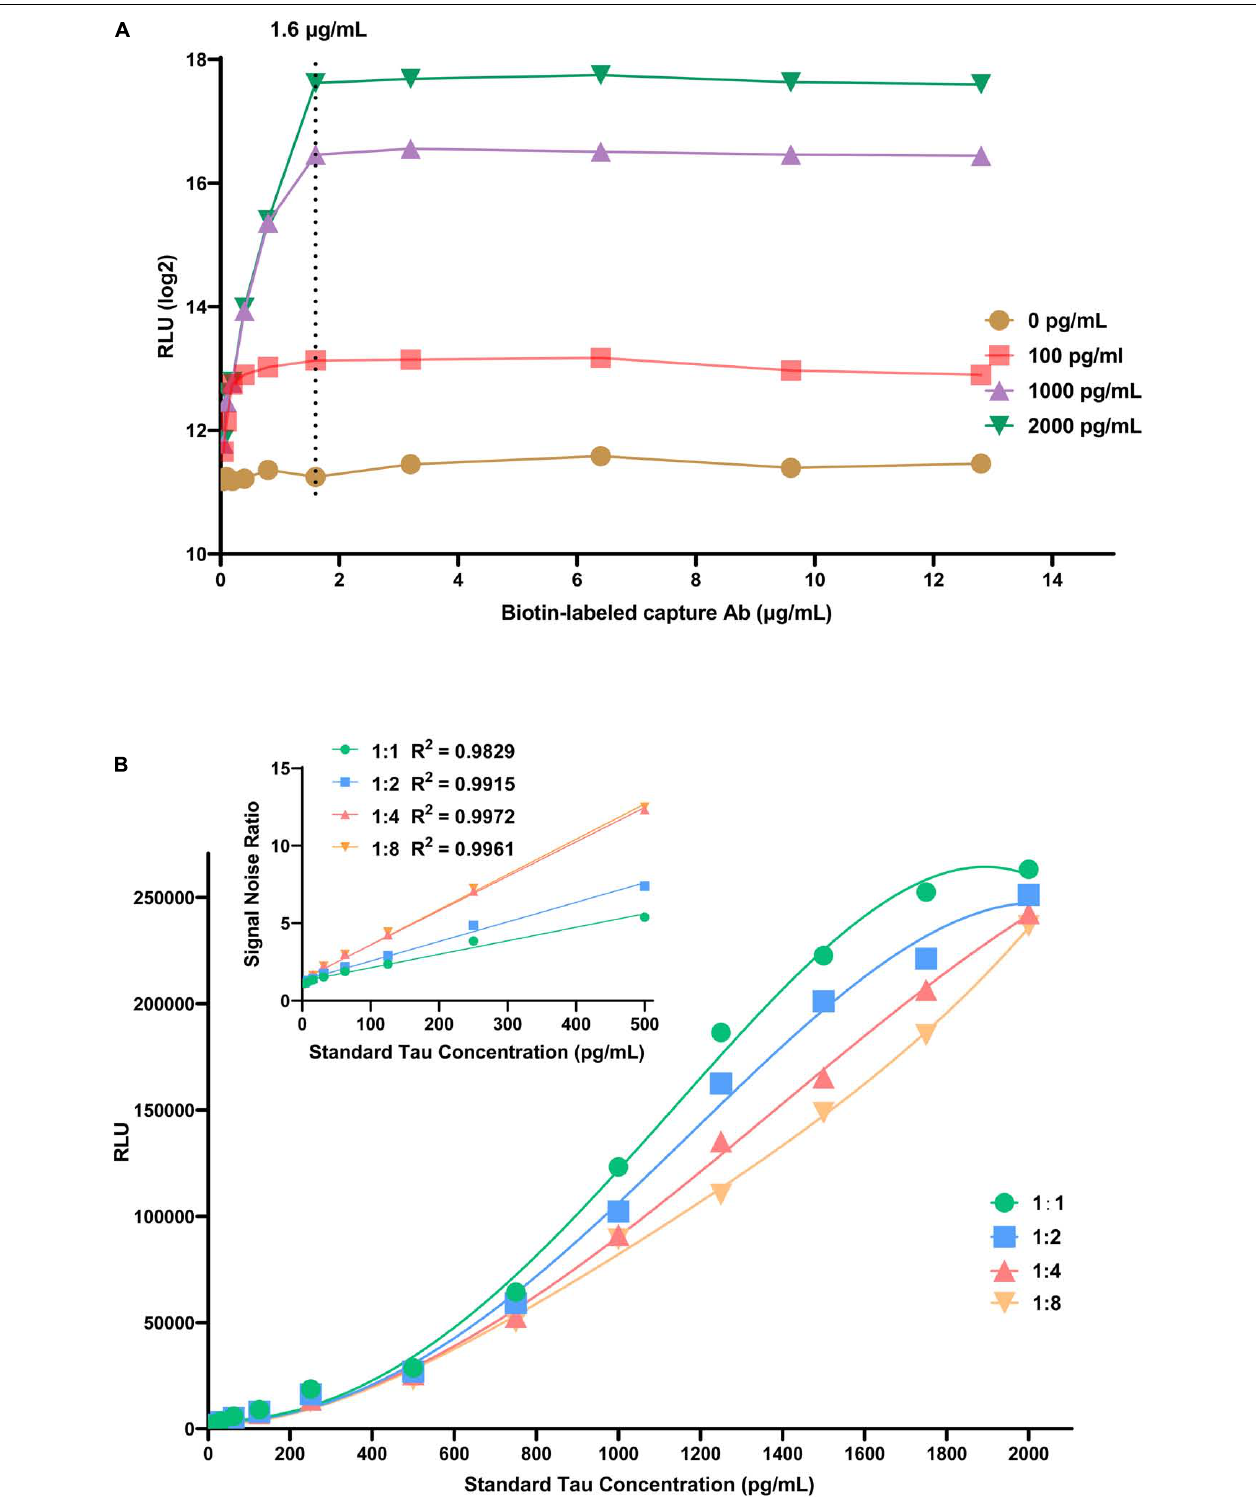
FIGURE 2 | The effects of experimental conditions on CLIA performance. (A) The effect of biotin-labeled capture antibody. (B) The effect of dilution times of AE-labeled detection antibody.